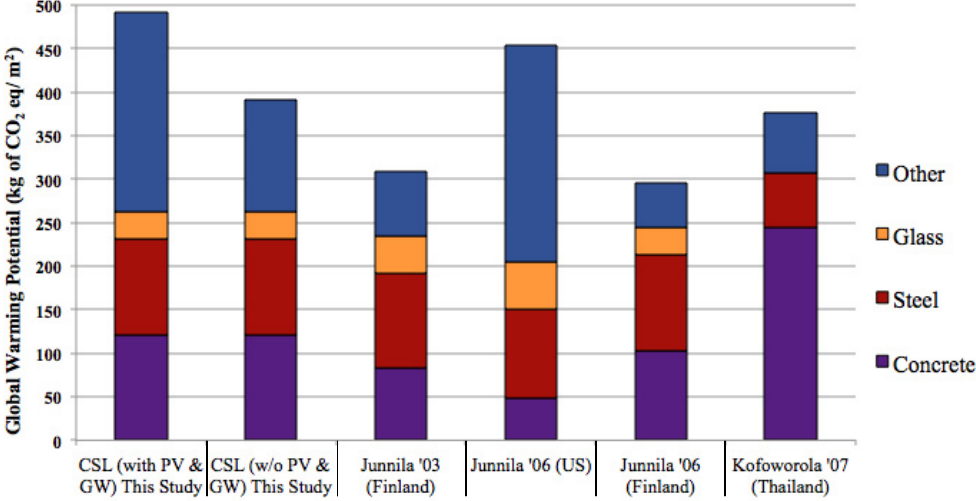
Figure 4. Global warming potential of the CSL compared to the published